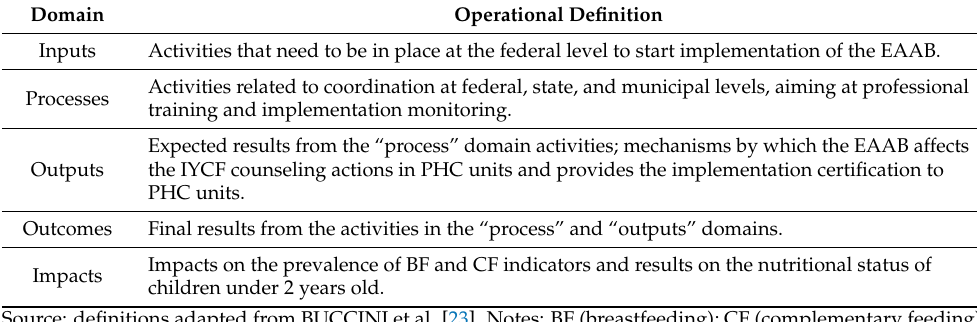
Table 1. Operational definition of the PIP diagram